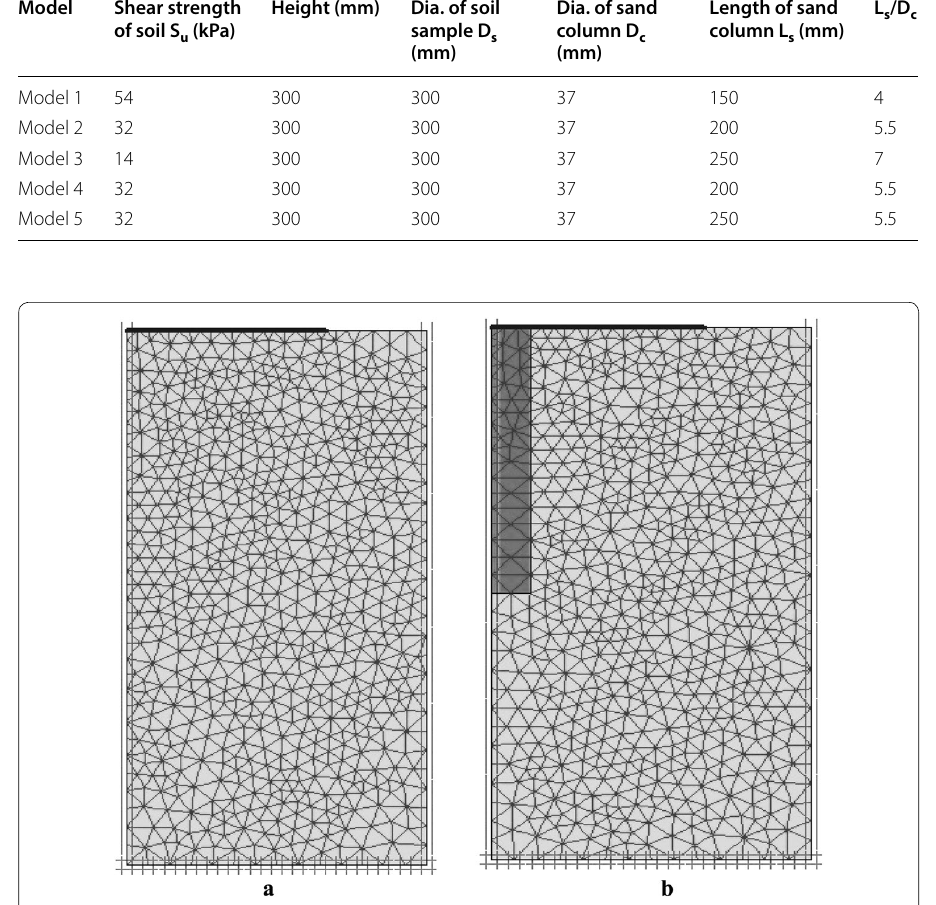
Fig. 5 FM Mesh (axisymmetric) a without sand column, b with sand